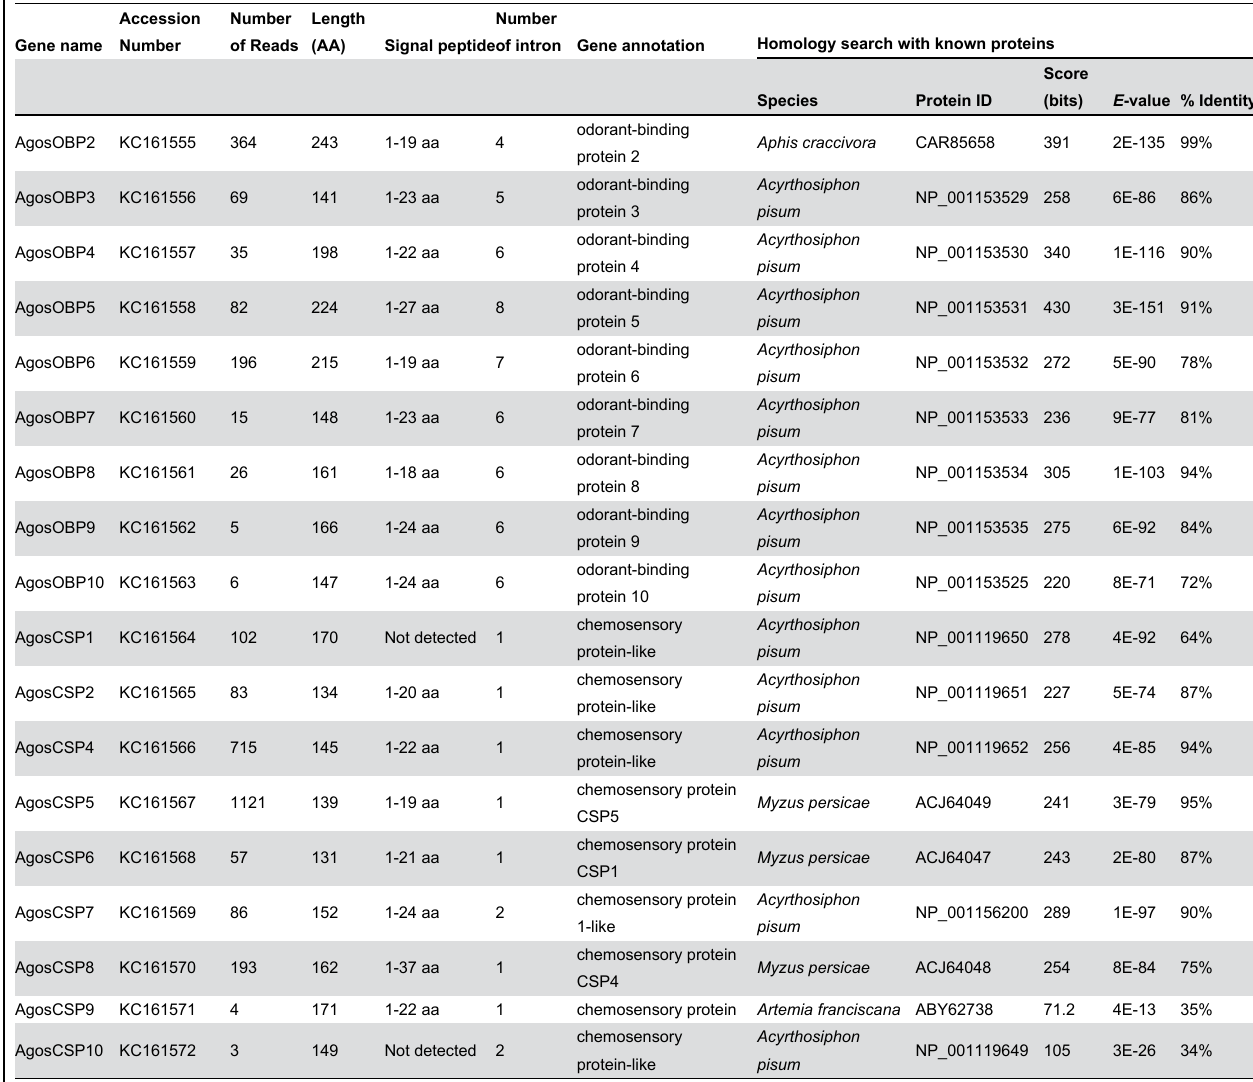
Gene name, name of genes identified from A. gossypii . Length, number of amino acids including signal peptide region. Species, source species of homologous gene. Protein ID: specific number of homologs on public database. E -value, the statistical significance of reported matches. % Identities, Percentage of amino acid identities between A. gossypii and